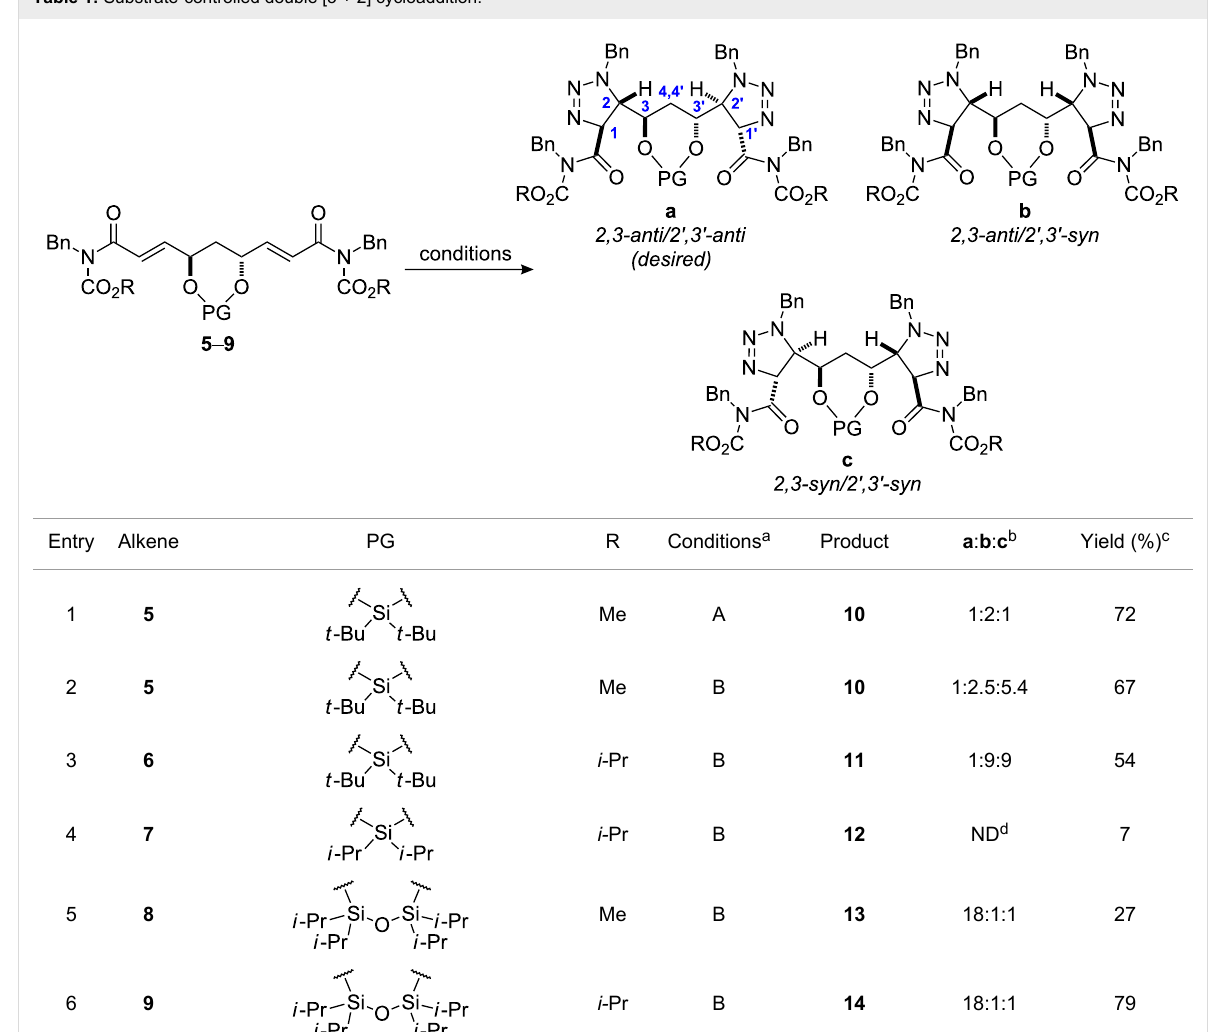
Table 1: Substrate-controlled double [3 + 2] cycloaddition.